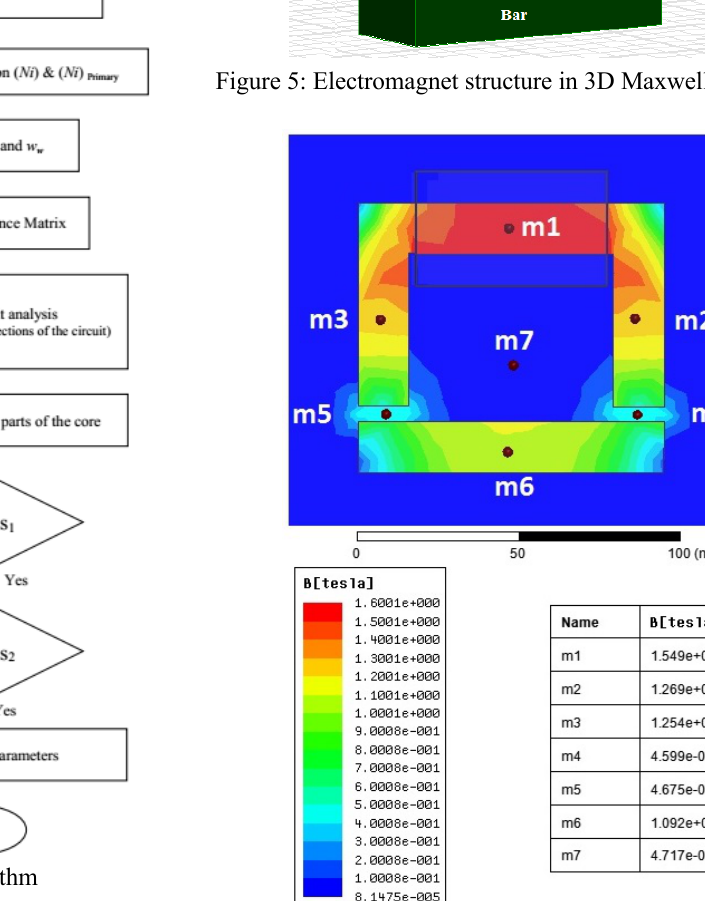
Figure 4: Proposed design algorithm